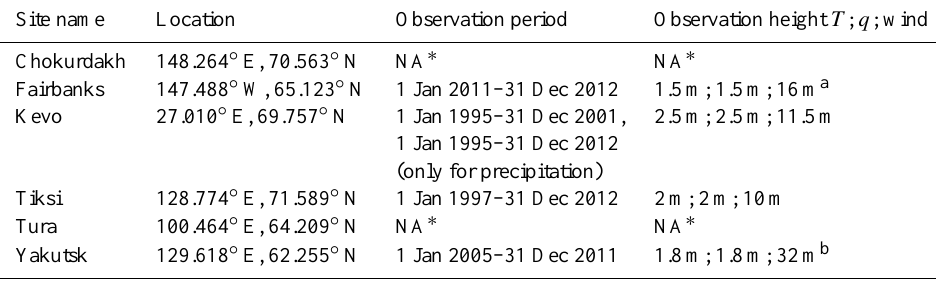
Table 1. Names and coordinates of the observation sites.